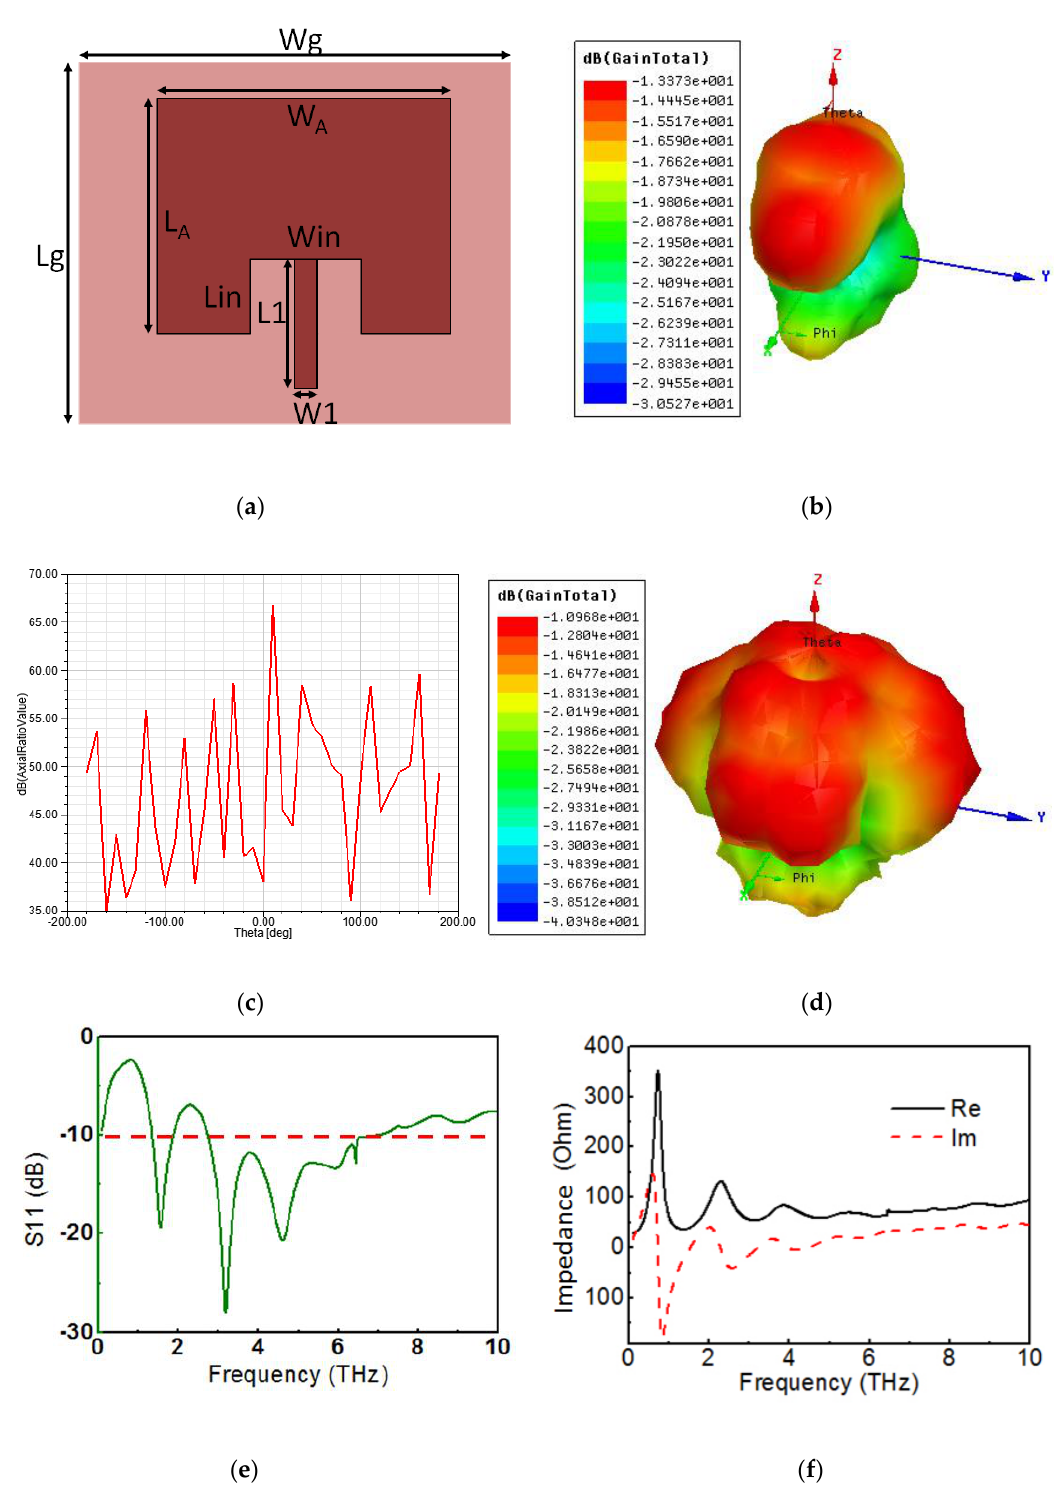
Figure 4. ( a ) Structure of graphene antenna (W A is the width of the radiation patch, and L A is the length of the patch. Wg is the width of the ground plan, Lg the length of the ground, W in the width of the slot, L in the length of the slot, W1 the width of the micro-strip line, and L1 the length of the micro-strip line), ( b ) antenna gain of single antenna, ( c ) axial ratio value, ( d ) antenna gain of two antennas, ( e ) S11, and ( f ) impedance of graphene antenna.